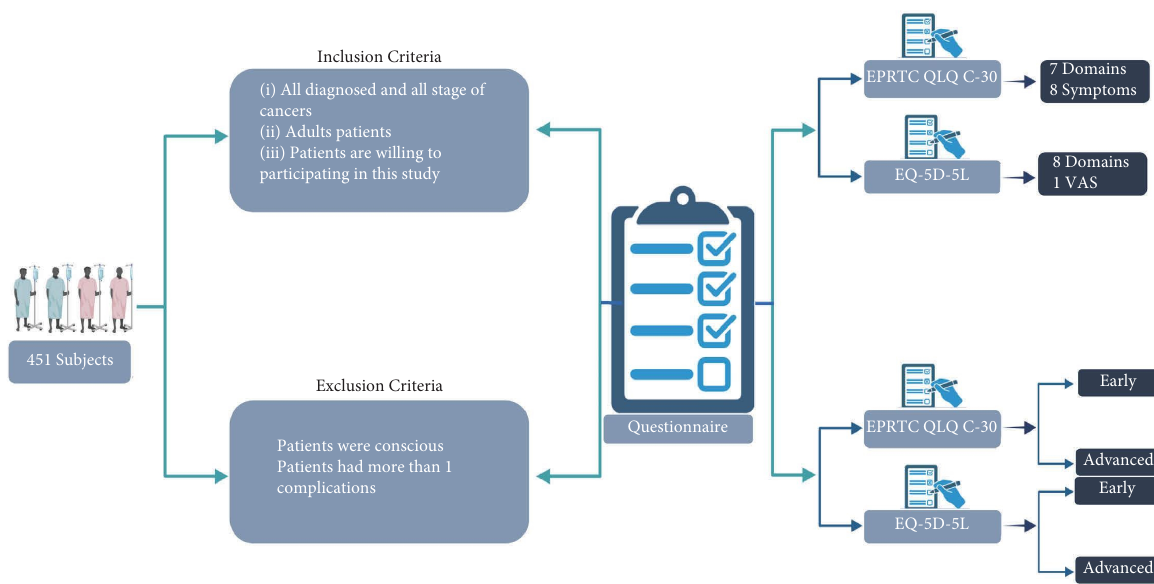
Figure 1: Workfow of the study. Table 1: Transformation scoring for EORTC QLQ-C30.